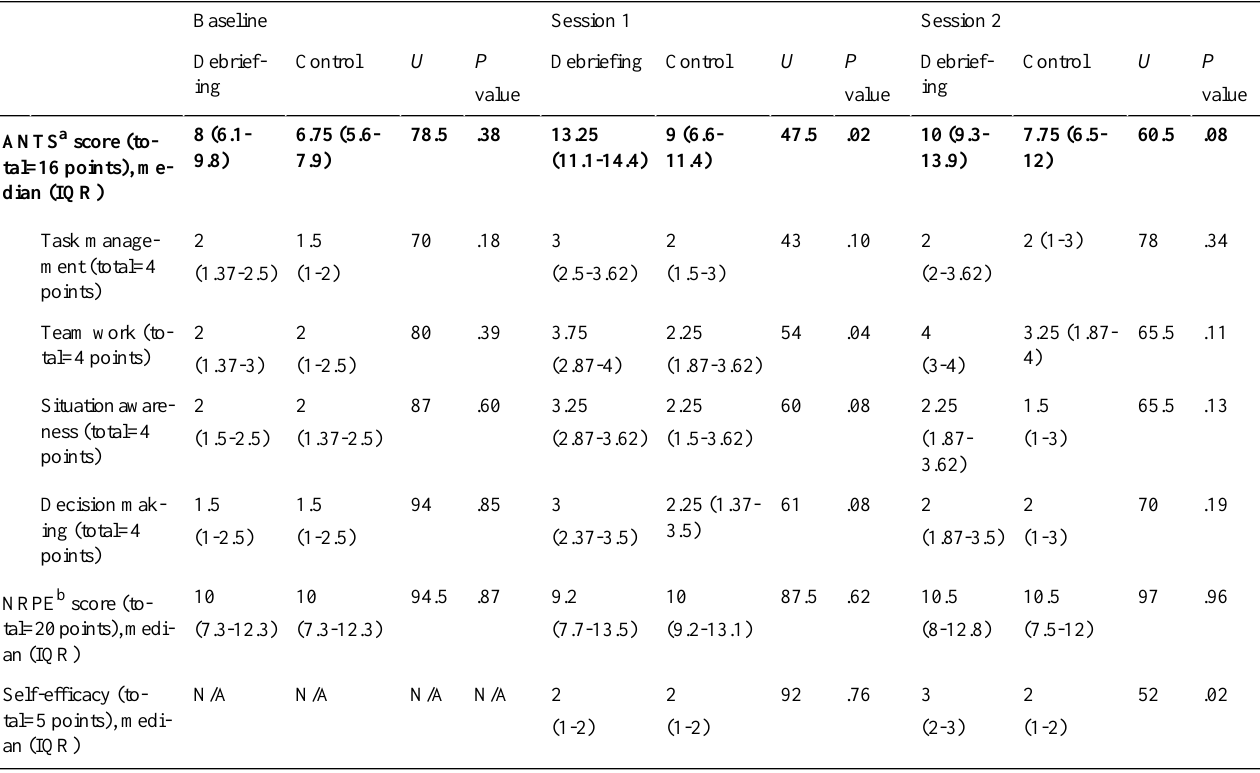
Table 2. Comparison of the nontechnical skills, technical skills, and self-efficacy evaluation between the debriefing and control